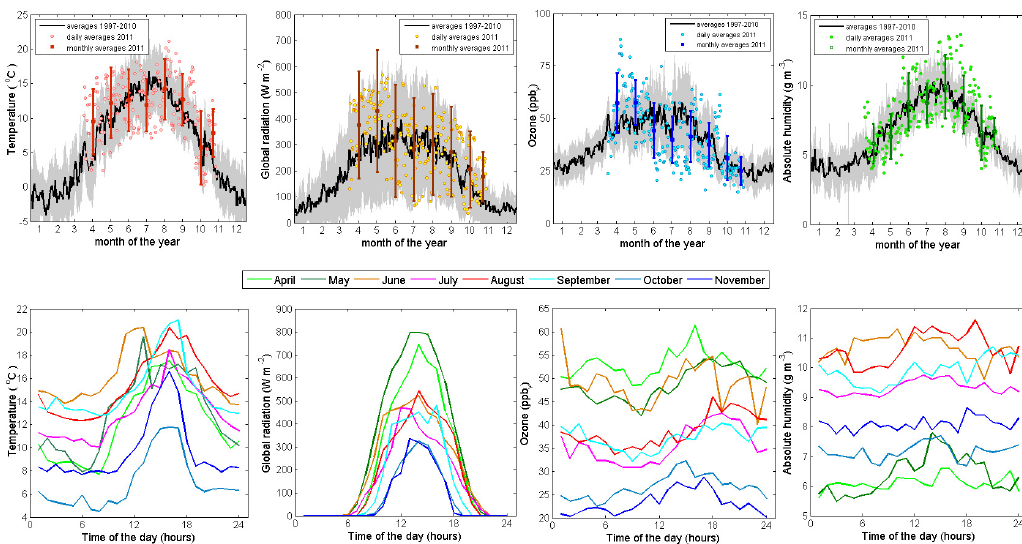
Figure 2. Top: climatological observations of temperature, global radiation, ozone and absolute humidity. The black continuous line repre- sents the daily average from the years 1997 to 2010 and the shading their standard deviation. Daily means of the year 2011 are shown as circles, while the error bars represent the monthly means with respective standard deviations. Bottom: monthly diurnal cycles for temperature, global radiation, ozone and absolute humidity. Table 1. Median, minimum and maximum fluxes calculated for all the compounds, measured in ngg(dw) − 1 h − 1 . The maximum fluxes observed during summer occurred simultaneously after a storm event as a result of mechanical stress. Spring Summer Autumn median